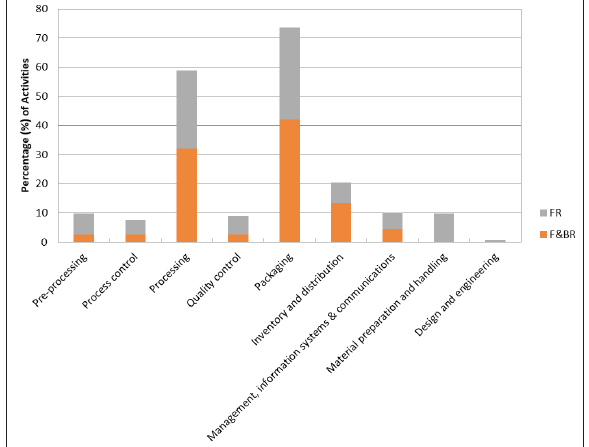
Figure 5: Focus areas of scientific and technological advances from Food & Beverage Reporter (F&BR) and South African Food Review (FR) data.